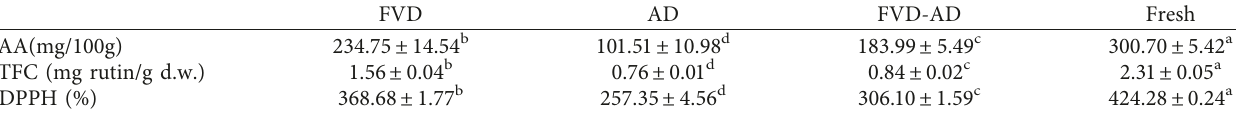
Table 3: Changes in total flavonoid and phenolic content and antioxidant activity of kiwifruits dried by different drying methods. FVD